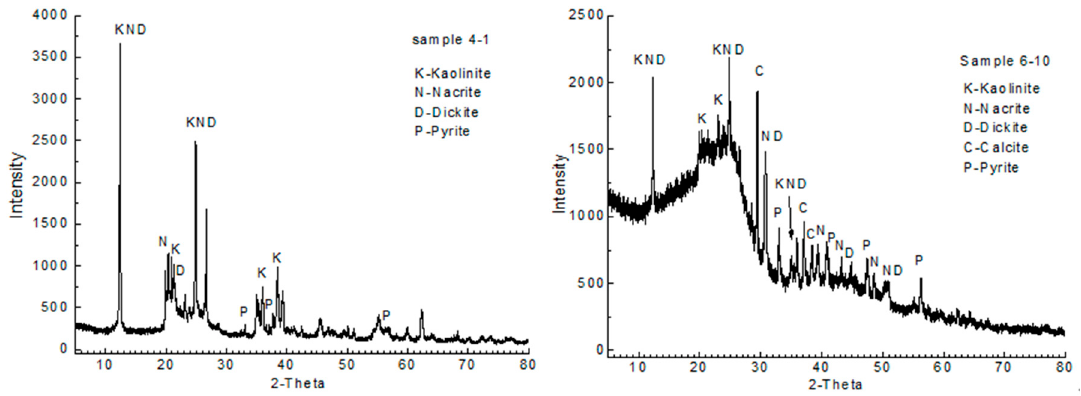
Figure 10. The X-ray diffraction (XRD) map for No. 4 and No. 6 coal samples.